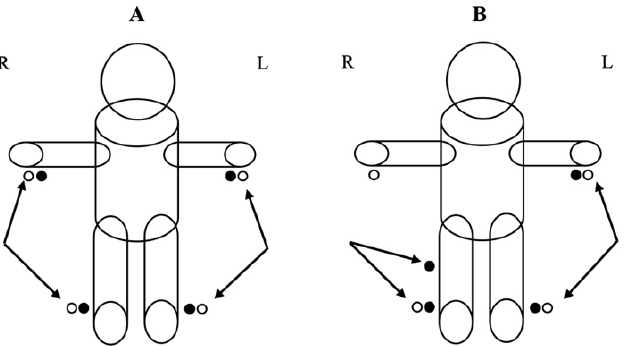
Figure 1. Depicture of whole-body analysis ( A ) and localized analysis ( B ). (R — right side, L — left side). The filled balls represent the voltage electrodes, and the blank balls represent the current electrodes. The coefficients of variation in our laboratory for repeated within-day R and Xc measures were, respectively; 1.6% and 1.9% for the right arm; 1.9% and 1.7% for the left arm; 1.9% and 1.9% for the right leg; 1.1% and 2.0% for the left leg; 1.3% and 0.1% for the right trunk; and 3.4% and 0.7% for the left